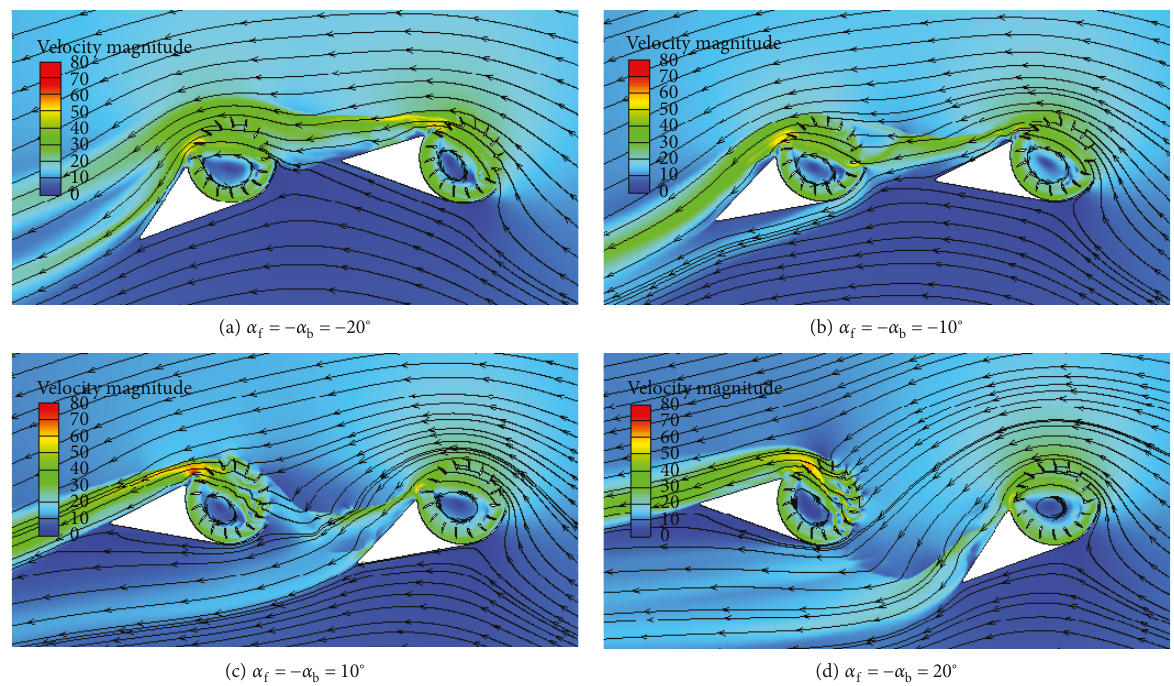
Figure 19: Velocitycontours andstreamlines ofthe frontand rear fan wings whenthe frontand rear wingshave the opposite installation angle.